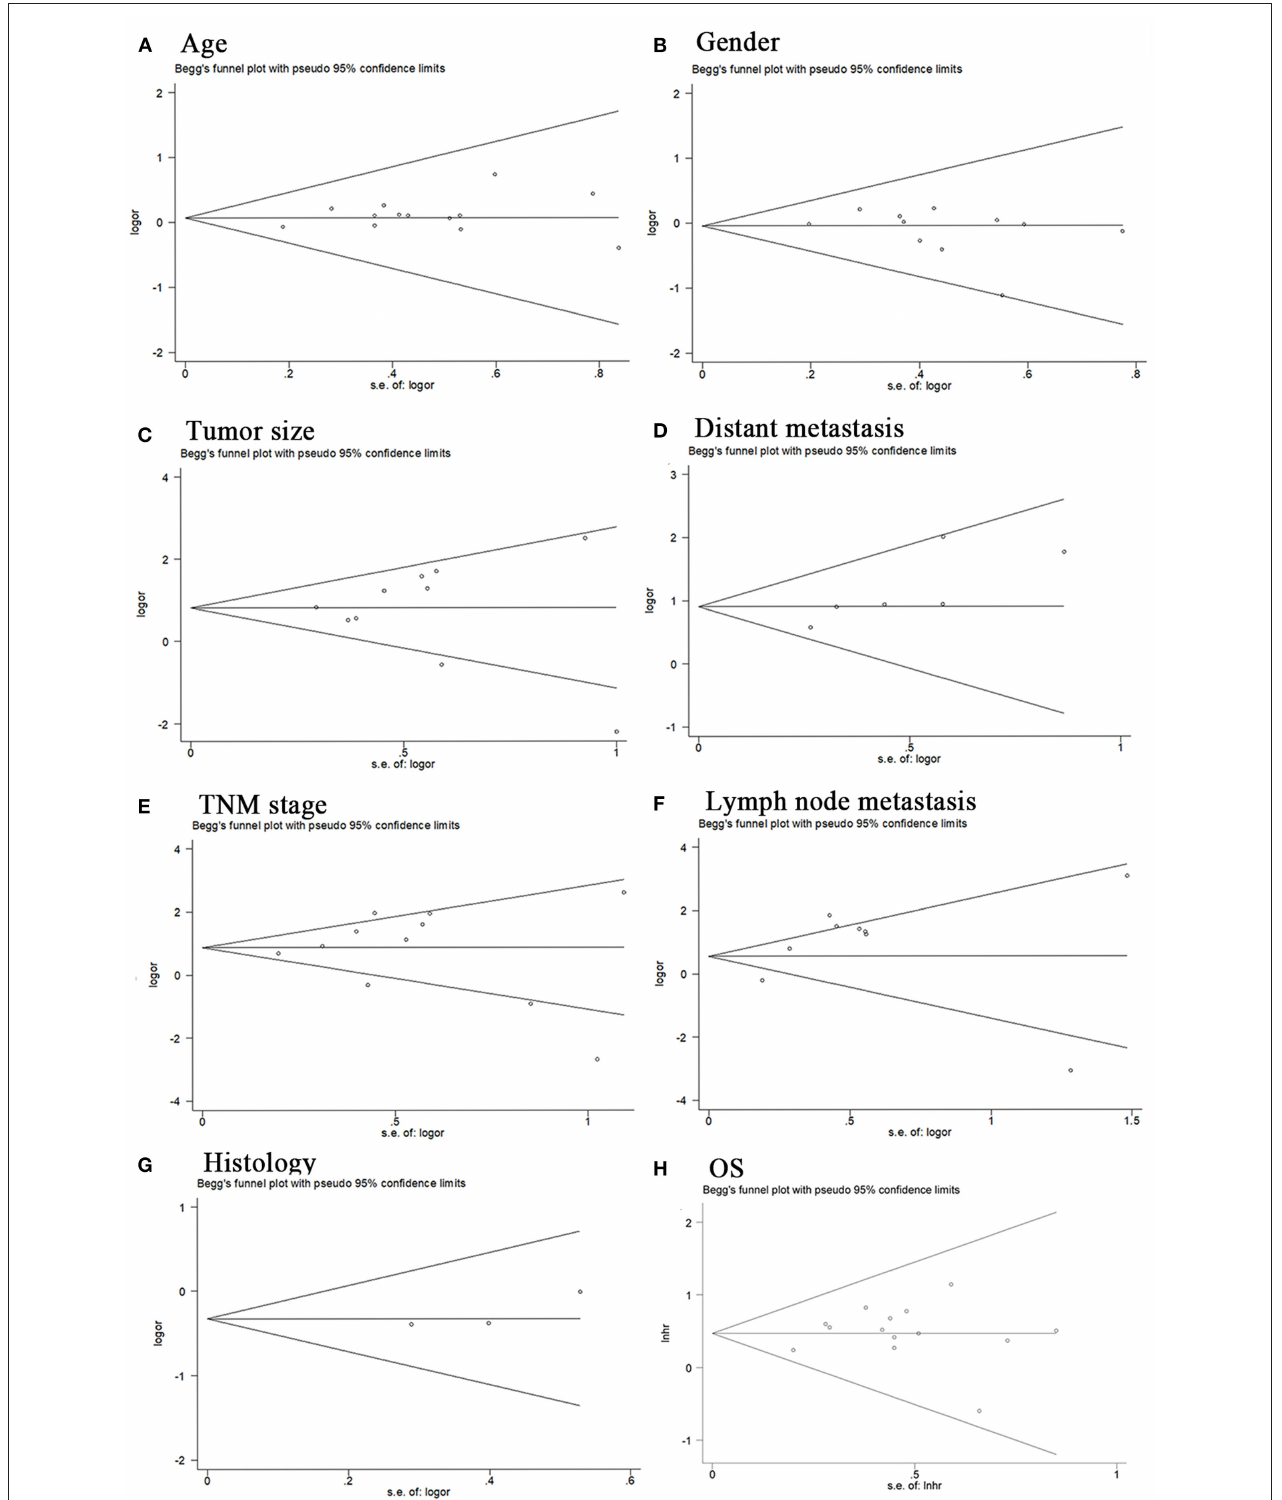
FIGURE 4 | Begg’s publication bias plots. Age (A) , Gender (B) , Tumor size (C) , Distant metastasis (D) , TNM stage (E) , Lymph node metastasis (F) , Histology (G) , OS (H) .